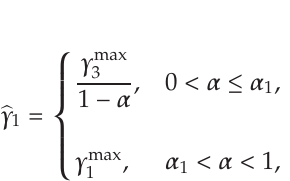
< γ max < γ max . (cid:4) b (cid:7) case γ max 3 2 1